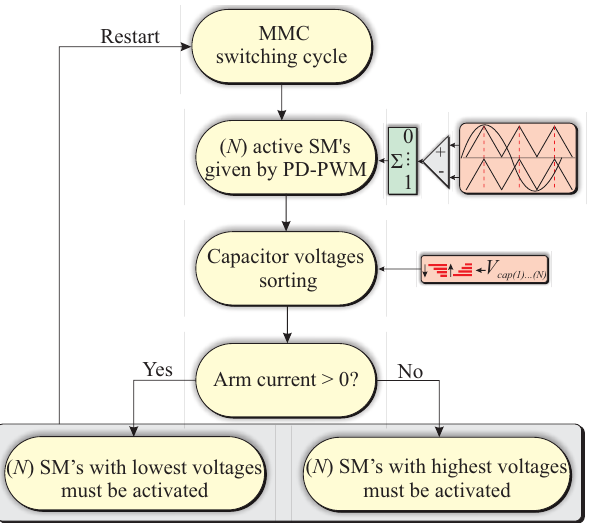
Figure 2. MMC capacitor voltage balancing